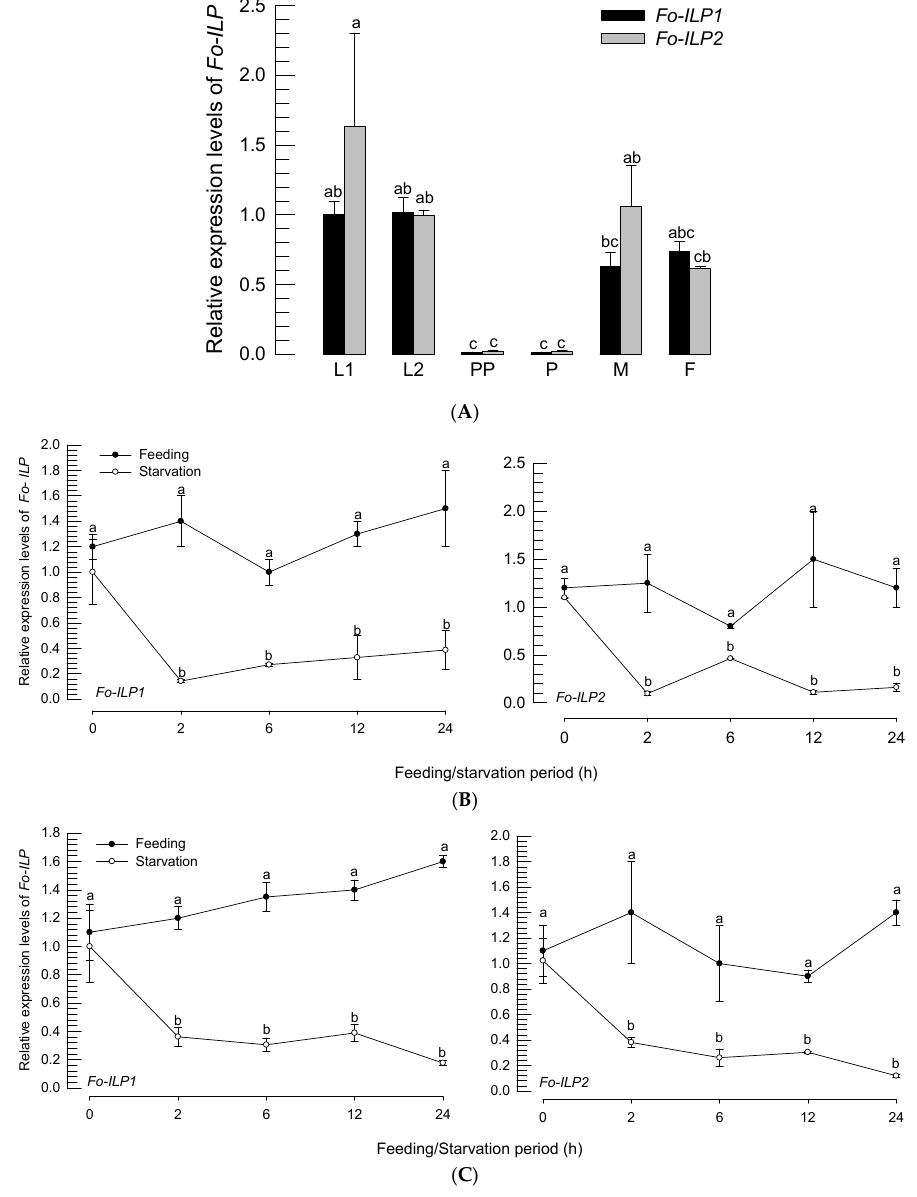
Figure 2. Expression profiles of the two ILPs ( Fo-ILP1 and Fo-ILP2 ) in F. occidentalis . ( A ) Expression patterns at different developmental stages: first and second instars (‘L1 ′ and ‘L2 ′ ), prepupa (‘PP’), pupa (‘P’), male adult (‘M’), and female adult (‘F’). ( B ) Effect of starvation on ILP expression in L2 larvae. ( C ) Effects of starvation on ILP expressions in female adults. Each treatment used 25 indi- viduals for cDNA preparation and was independently replicated three times. The letters above the